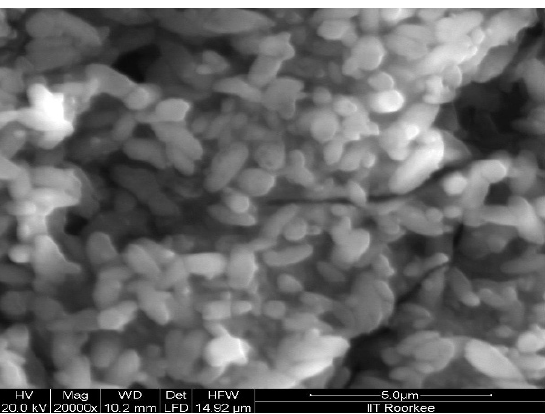
Figure 1. Scanning Electron Micrograph of Desulfotomaculum nigrif- icans bacteria on Stainless steel 304L after 72 hrs.